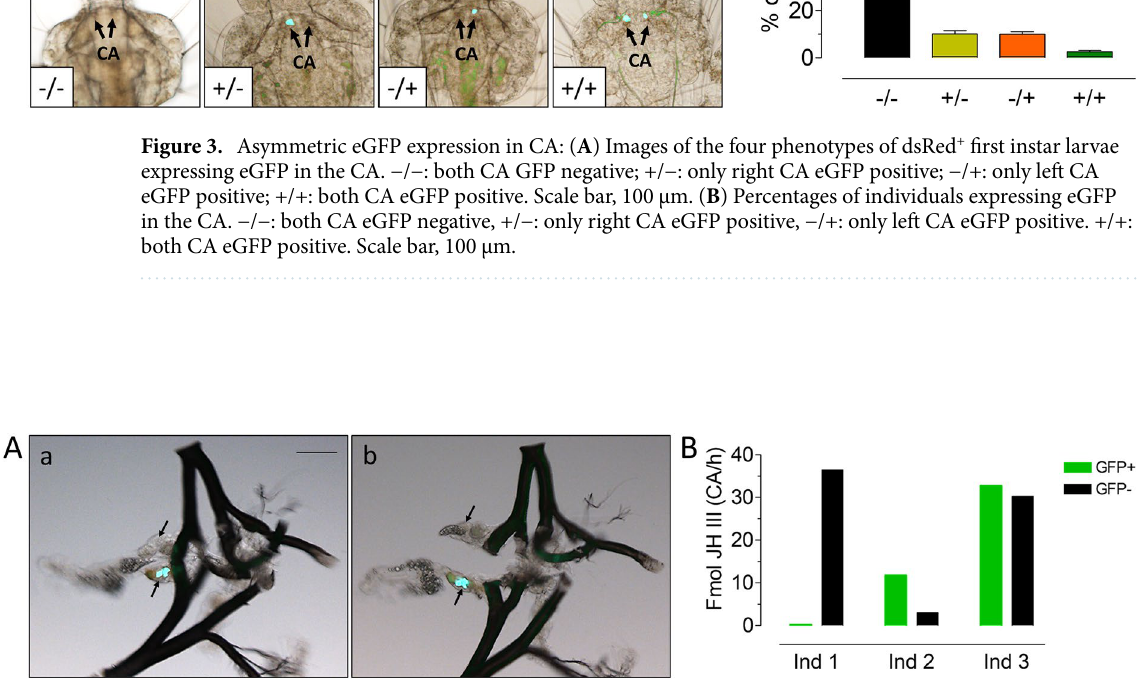
Figure 4. Lack of correlation between expression of eGFP and JH biosynthetic activity. Individual CAs were dissected from three insects expressing eGFP in only one CA, and JH biosynthesis was evaluated individually in each individual member of a CA pair. ( A ) Images of dissected CA, (a) before and (b) after separation of individual CA. ( B ) Amount of synthesized JH expressed as fmol of JH III/CA/h. Green bars: CA from GFP + , Black bars: CA from GFP - . Scale bar, 100